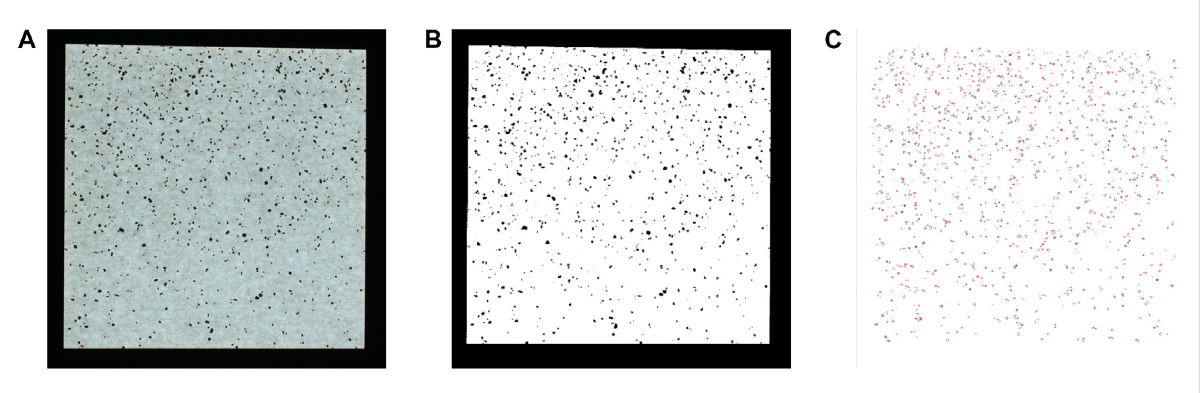
FIGURE 6 Image analysis: (A) is an original vermiculite sample picture taken by a camera. (B) is the corresponding image edited by ImageJ for analysis. (C) shows the vermiculite particles detected by ImageJ.